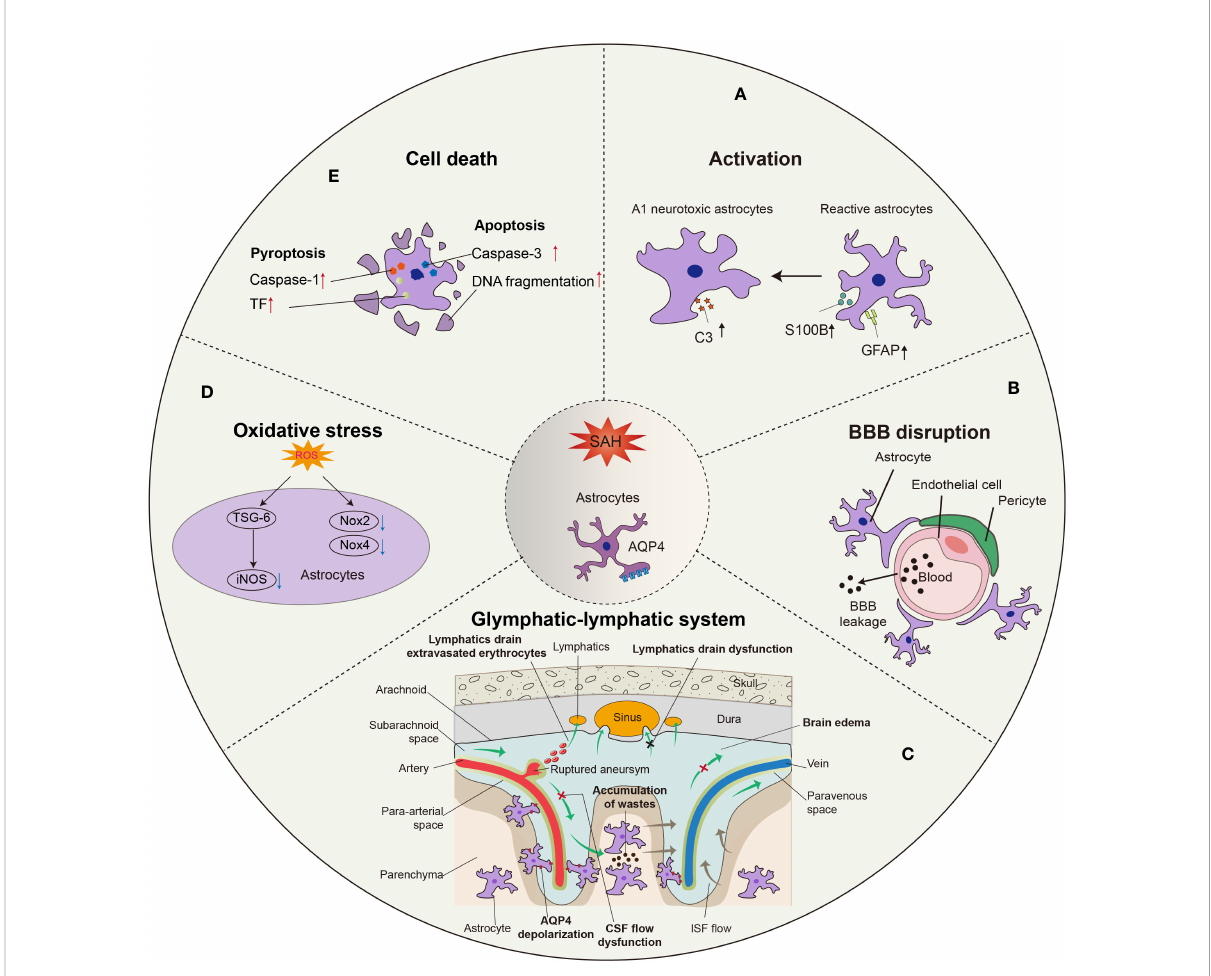
FIGURE 1 Morphological and functional changes in astrocytes after SAH. (A) Astrocytes are activated into predominant neurotoxic A1 subtype after SAH. (B) Astrocytes are involved in the disruption of BBB integrity due to SAH, leading to the leakage of circulatory neurotoxic substances into the parenchyma. (C) Astrocytes-constituted glymphatic-lymphatic system is impaired due to the hemorrhage in subarachnoid space, resulting in subsequent brain edema. The polarity of AQP4 in astrocytic endfeet is decreased after SAH. (D) Excess ROS in astrocytes is related to the oxidative stress after SAH, in which iNOS, Nox2, and Nox4 play critical roles. (E) The apoptosis of astrocytes occurs earlier than neurons after SAH, probably in a caspase-dependent